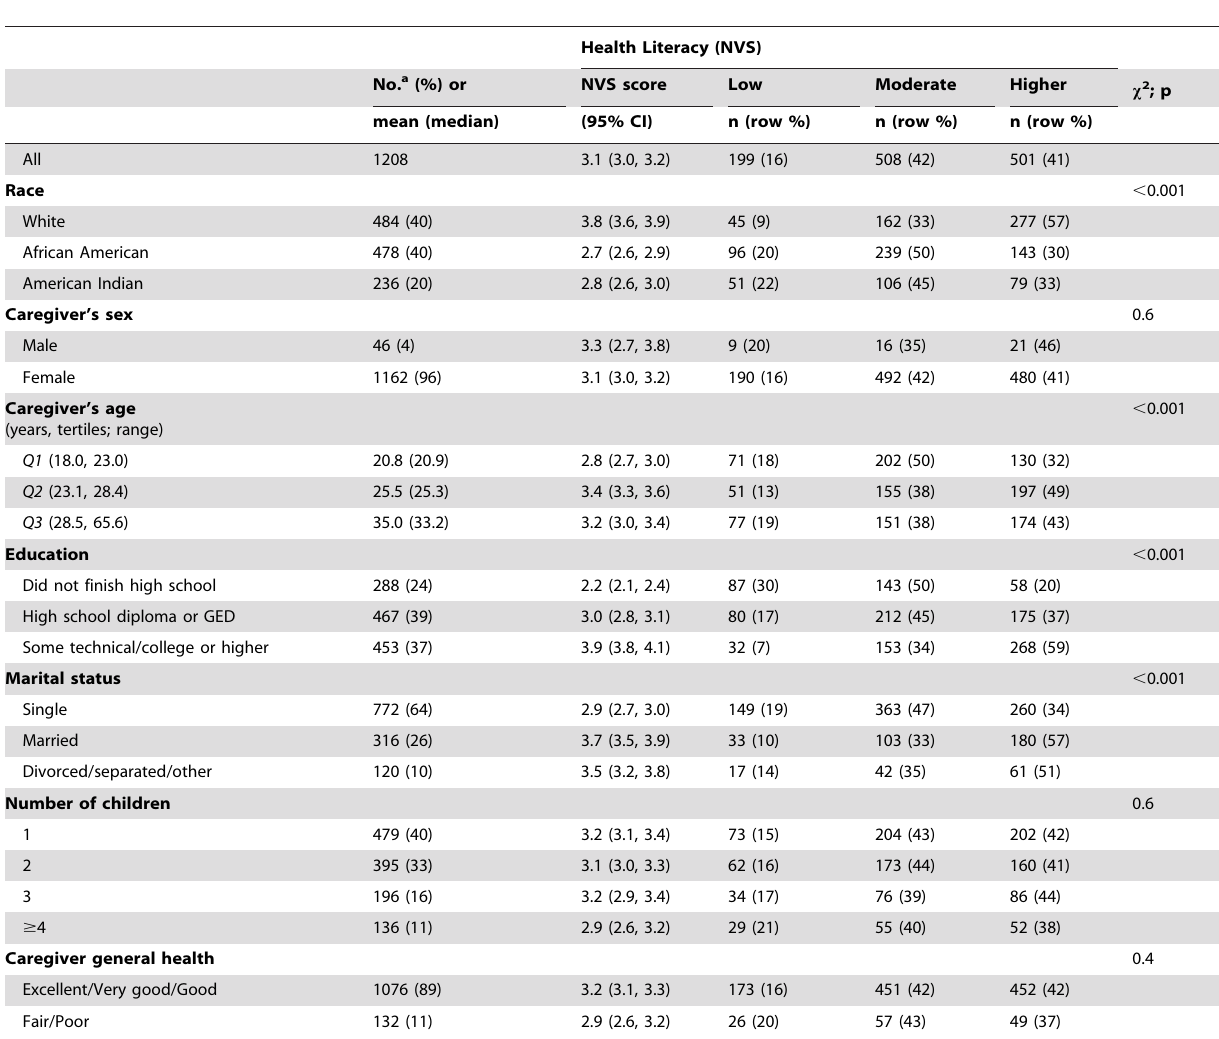
Table 1. Distribution of Health Literacy Estimates (NVS) across Levels of Caregivers’ Characteristics, in the COHL Study Follow-up Cohort, North Carolina,